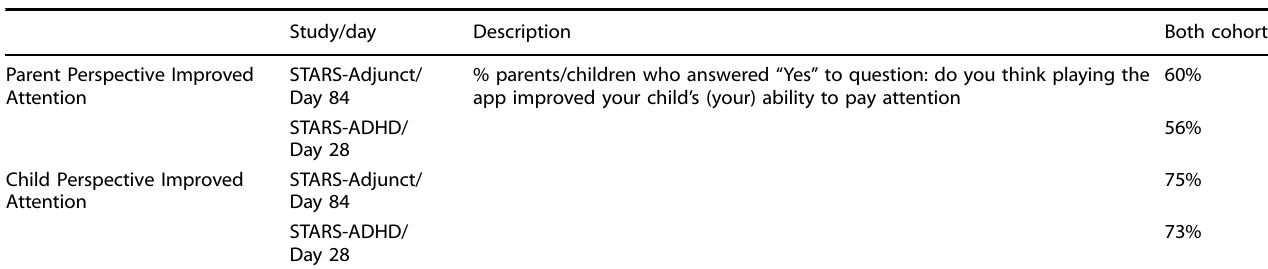
Table 4. Parent and child perspective: improved attention.